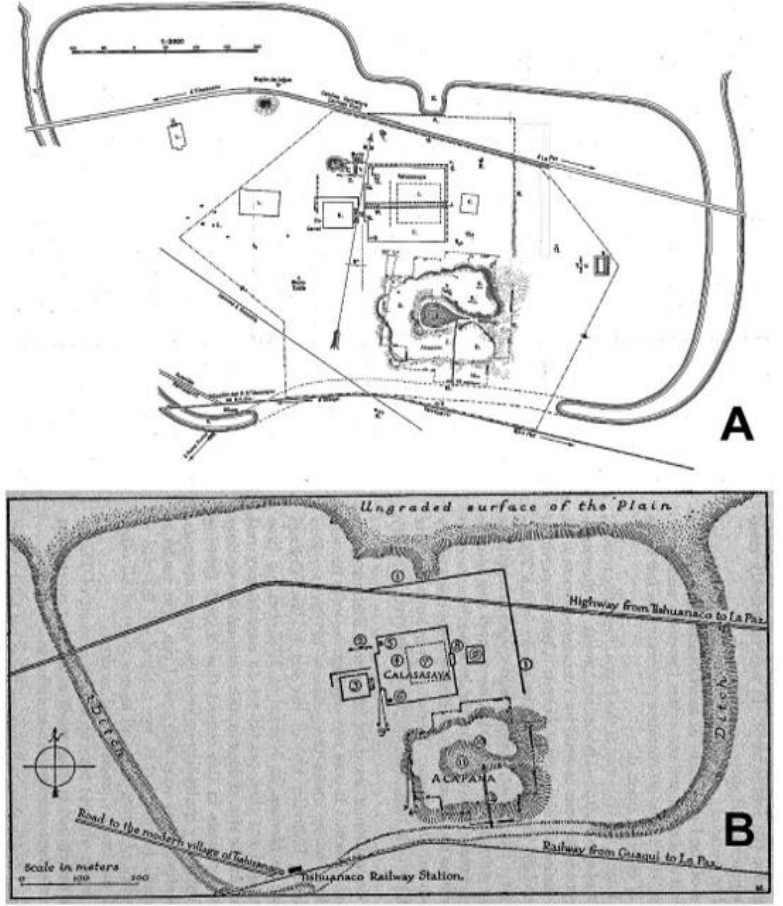
Figure 43. Early ground drawings of the moat structure by Bandelier 1911 ( A ) and Bennett 1934 ( B ) References [37,38].